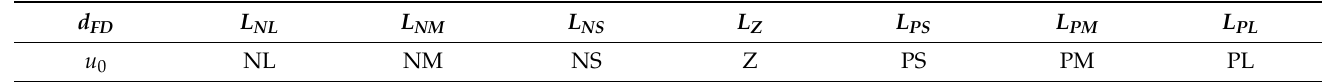
Table 3. Simplified rule table using e and a D α